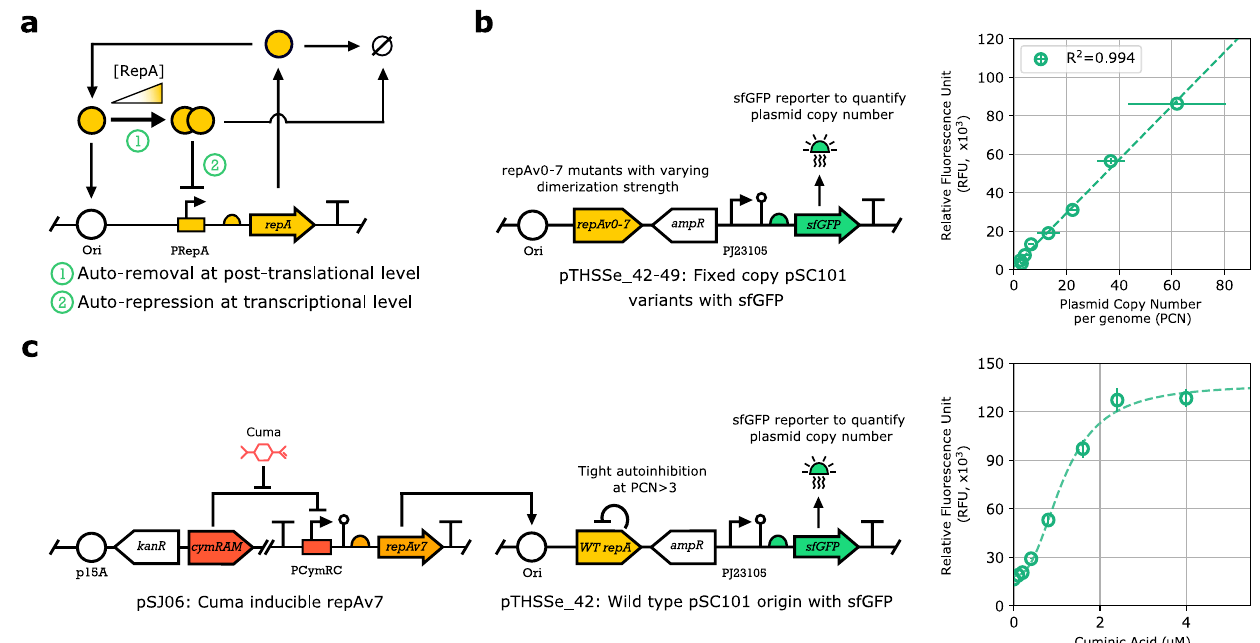
Fig. 1 | PCN control offers a powerful avenue for regulating gene expression. a Auto-regulating architecture of PCN control relying on the WT pSC101 origin of replication: RepAupregulates PCNinits monomeric form, and downregulatesitas a homodimer. b Linear plasmid map of the pSC101-repA variants with fi xed PCN (fPCN collection), each carrying identical constitutive sfGFP gene cassette and antibiotic resistance marker. PCN (measured via qPCR) and relative fl uorescence intensity (measured via fl ow cytometry) for the fPCN collection show strong linear